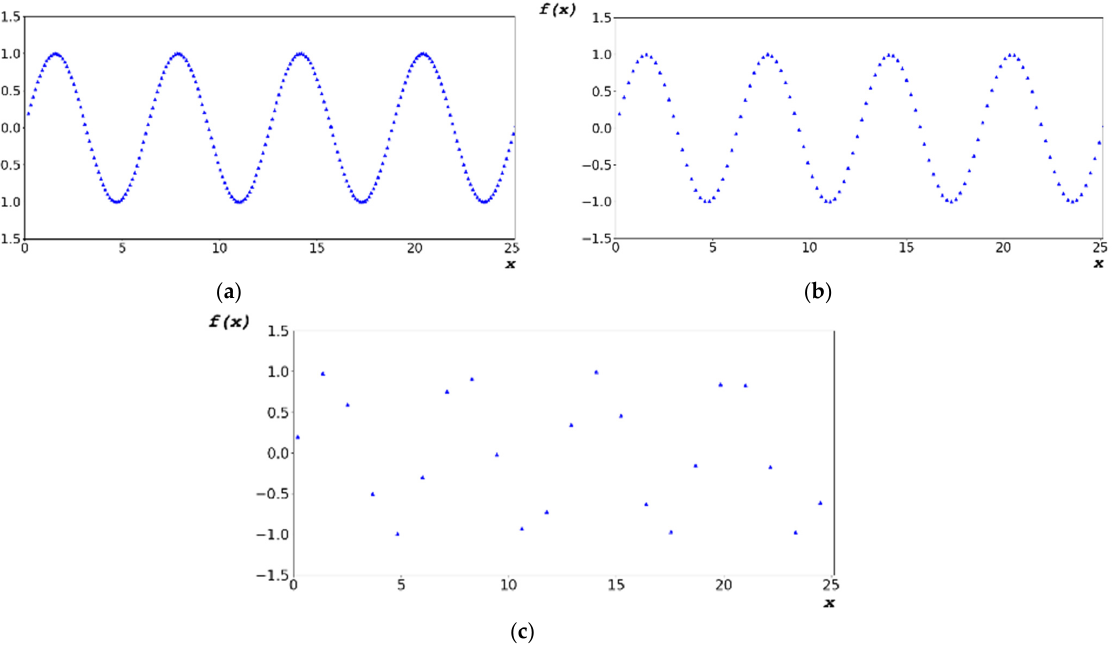
Figure 7. Periodic functions yielded using designed algorithms at ( a ) dx = 0.1156 rad, ( b ) dx = 0.2312 rad, and ( c ) dx = 1.1560 rad.